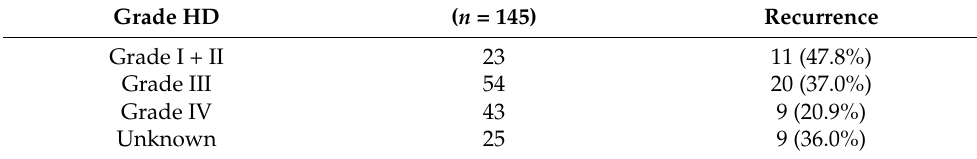
Figure 4. Kaplan–Meier curve of freedom of recurrence. ( a ) According to grade of haemorrhoidal disease. ( b ) According to follow-up time. Table 4. Distribution of recurrence according to HD grade (HD = haemorrhoidal disease, n = number).